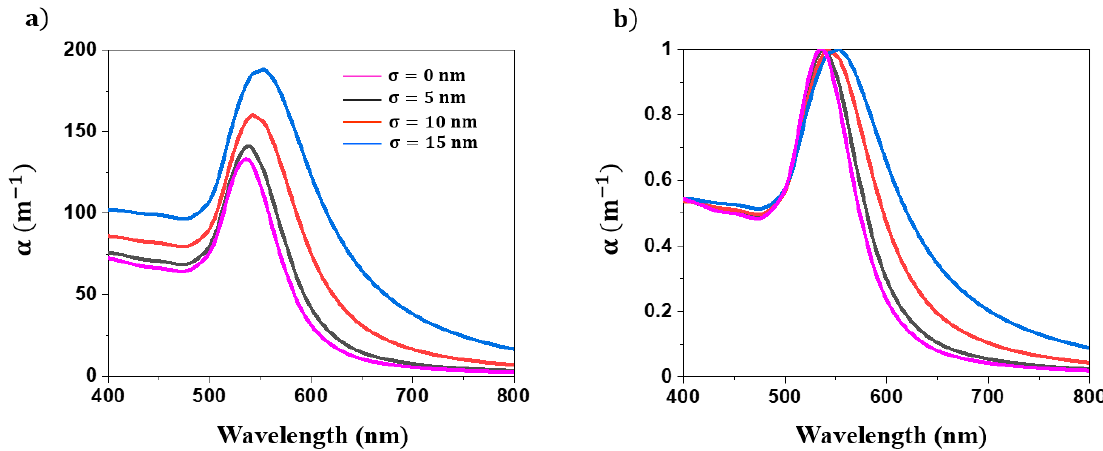
Figure 3. ( a ) Influence of the standard deviation ( σ ) of the Au NPs size distribution on their extinction spectra. ( b ) Normalized extinction spectra of Au NPs. These simulations are performed by considering a Gaussian distribution centered at 30 nm. The concentration of NPs is set to 10 20 m − 3 .